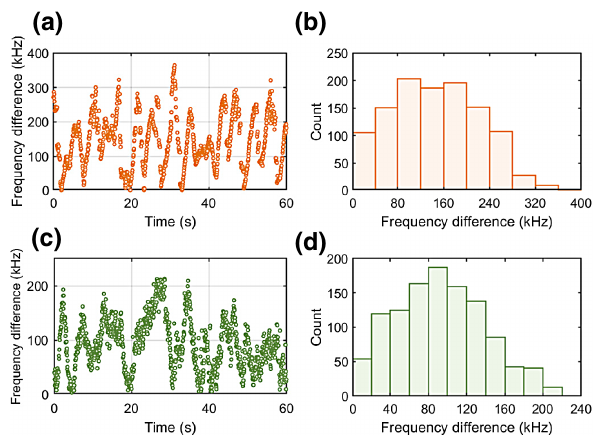
FIG. 5. Test results of the frequency difference between two independent lasers, which are obtained by manually adjusting the temperature. (a) Frequency difference between two NKT lasers for 60 s. (b) Histogram of the frequency difference distribu- tion between two NKT lasers. The mean frequency difference is 145 kHz. (c) Frequency difference between two RIO Orion lasers of 60 s. (d) Histogram of the frequency difference distri- bution between two RIO Orion lasers, where the mean value is 92.5 kHz. Note that, if using automatic feedback systems, the frequency difference can be further